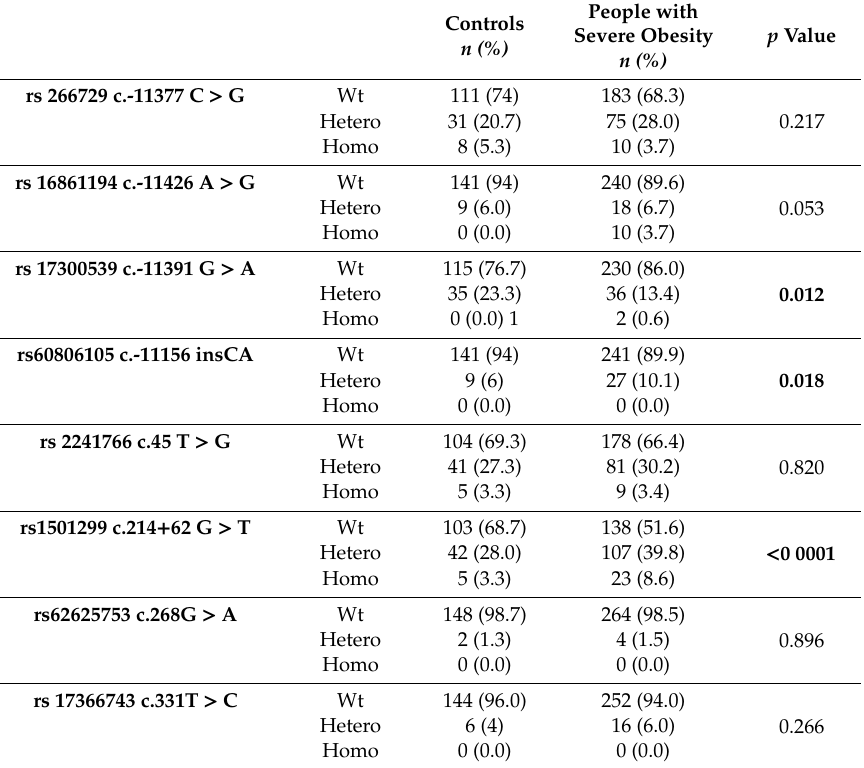
Table 3. Adiponectin considered polymorphisms in controls and people with severe obesity.